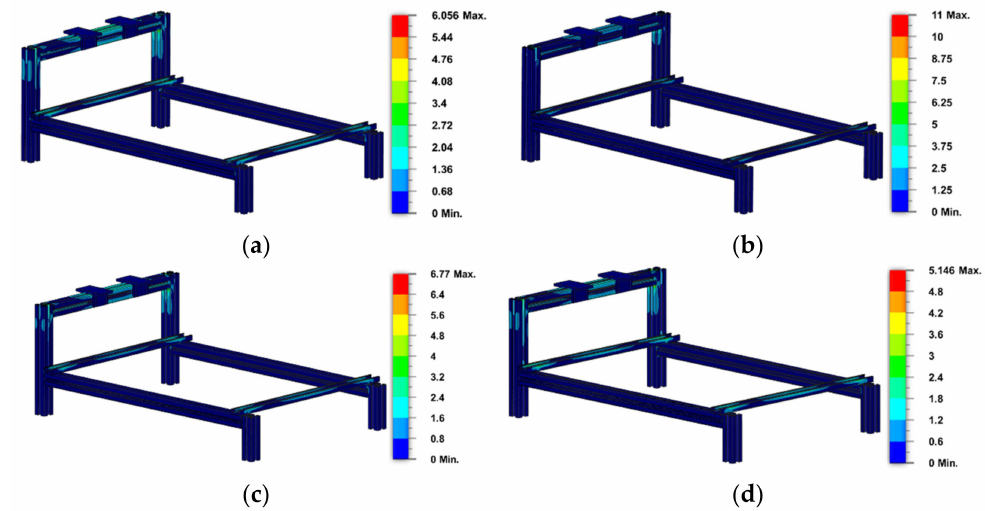
Figure 10. Contour of Von Mises Stress on Cantilever Crane: ( a ) Standard Type; ( b ) Lightweight Type; ( c ) Economy Type; ( d ) High-Rigidity